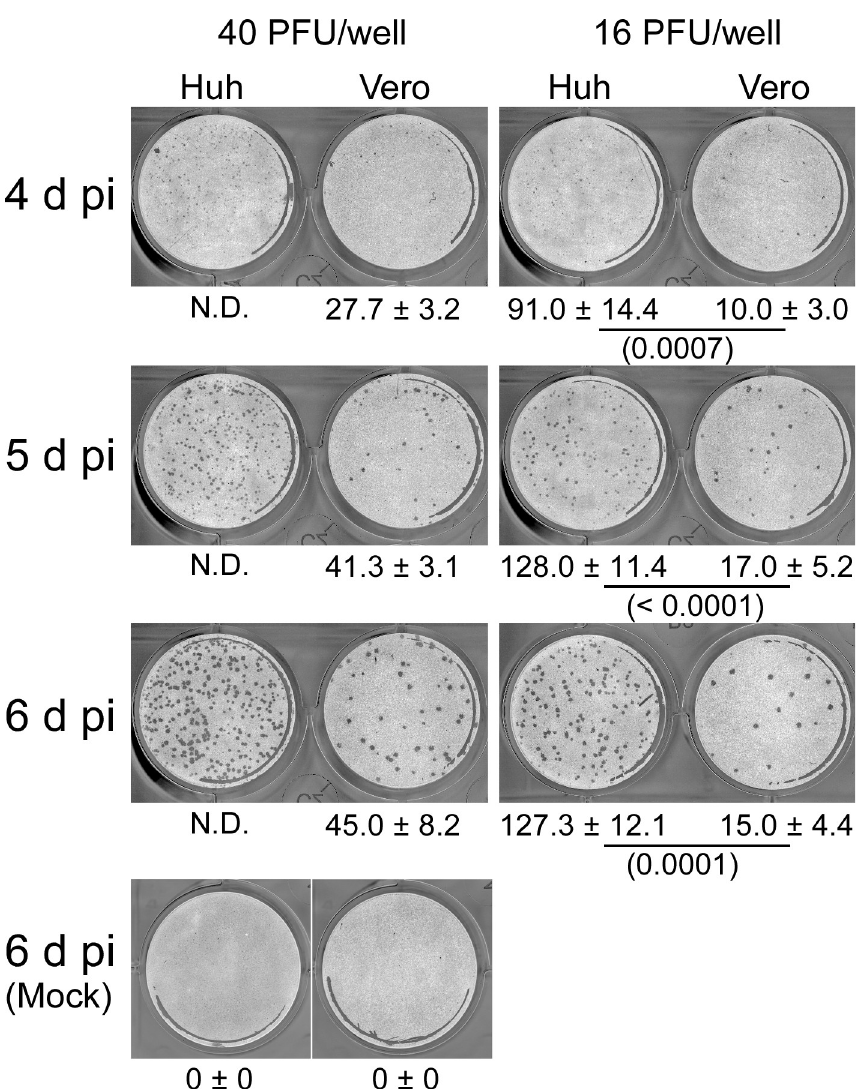
Fig 9. Huh7.5.1–8 cells developed larger numbers of YFV plaques than Vero cells. Representative black-and-white inverted images of YFV plaques in Huh7.5.1–8 (Huh) and Vero cells. Cells were infected with YFV (17D-204 strain) at either 40 or 16 PFU (determined with Vero cells) per well and then fixed and stained at the indicated times. Values below the images indicate plaque numbers expressed as the mean ± SD of triplicates from one representative experiment. Statistical significance was determined by an unpaired two-tailed t test. Values in parentheses indicate p values, and those less than 0.05 were considered statistically significant. Similar results were obtained in two other independent experiments (S9 Fig). N.D., not